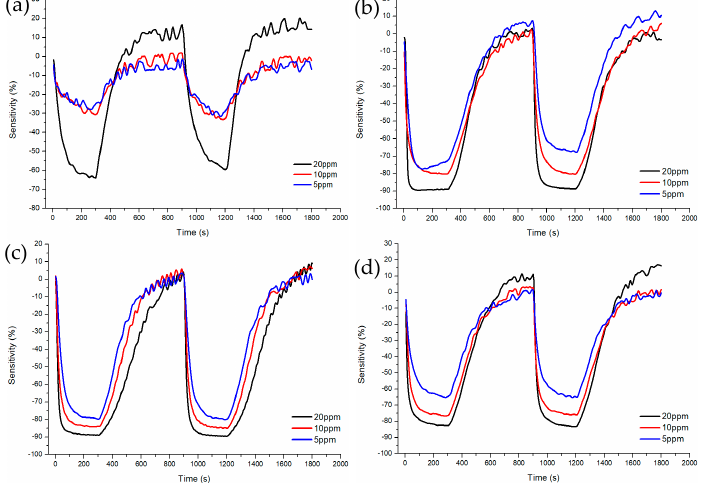
Figure 7. Characteristics of sensitivity and recovery rate of ZnO-TiO2 gas sensor for high concentration (5~20 ppm) formaldehyde gas. ( a ) ZnO(90%)-TiO 2 (10%) ( b ) ZnO(95%)-TiO 2 (5%) ( c ) ZnO(99%)-TiO 2 (1%) ( d ) ZnO(100%)-TiO 2